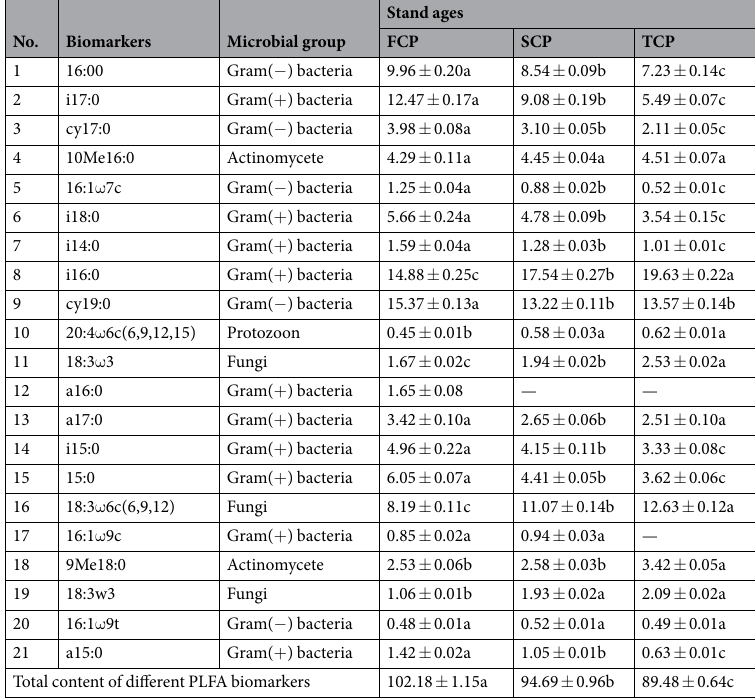
Table 2. Types and contents of PLFAs in three rotations plantations (ug·g − 1 ).